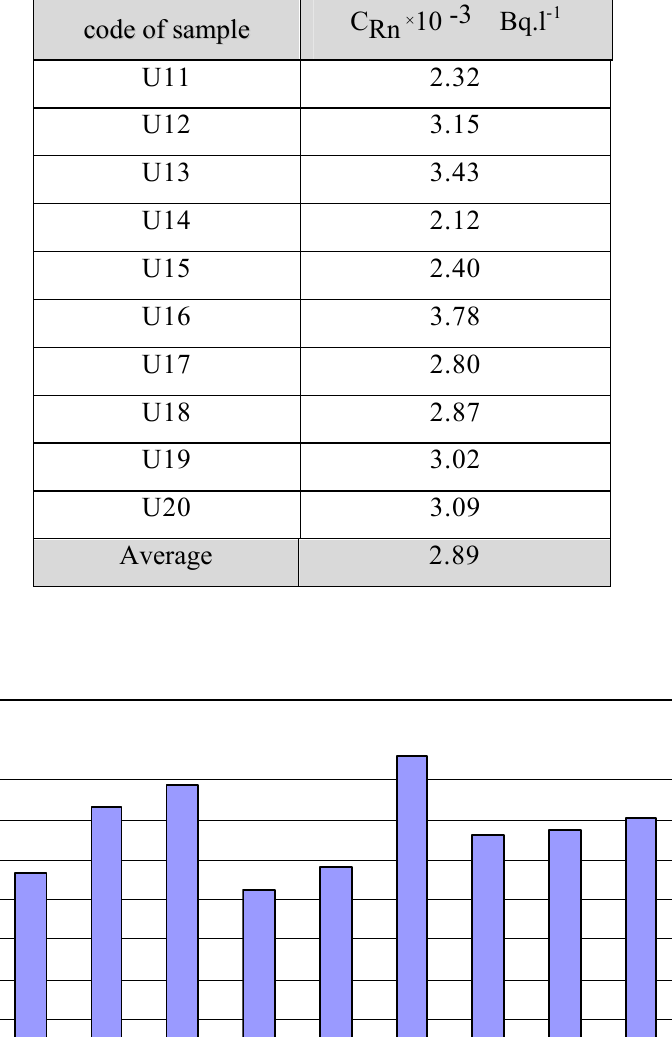
Table 4: Radon concentration in urine human of female samples.